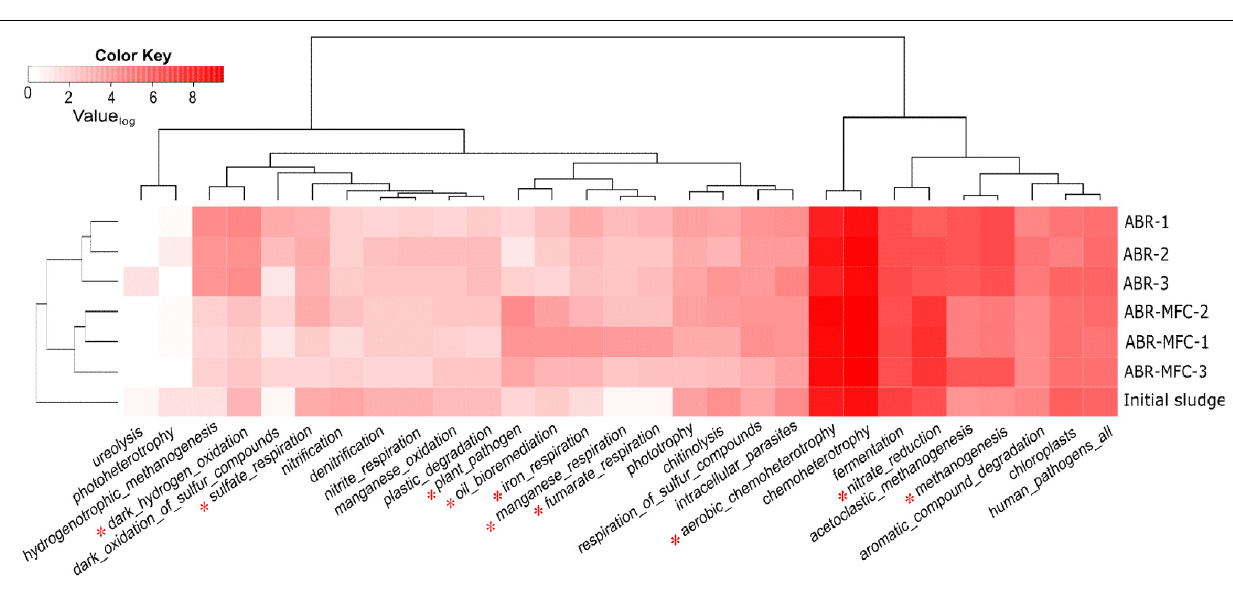
FIGURE 5 | Heat-map and cluster profiles of microbial functions in different chambers of ABR and MFC-ABR. Color-key indicates the Log 2 -value of the average OTU number ( n = 3). Only the functions with significant OTUs (i.e., average OUT number in all samples > 1) were shown. ∗ Indicates functions with significantly different OTU numbers in ABR and